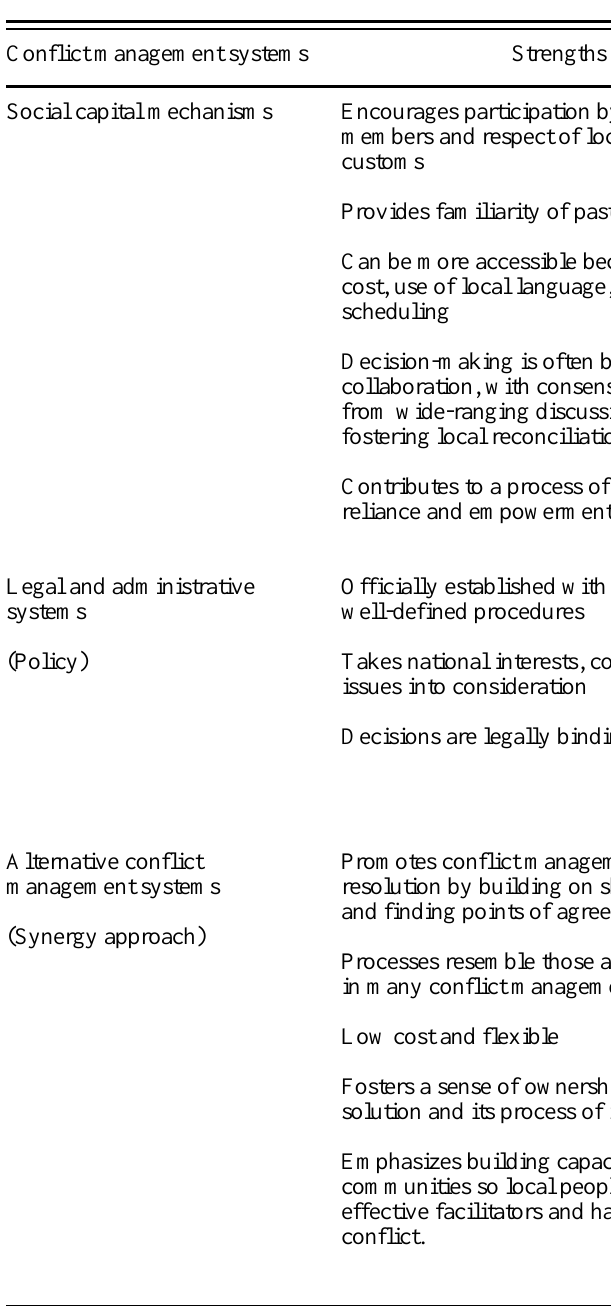
Table 5. Strengths and limitations of different conflict management